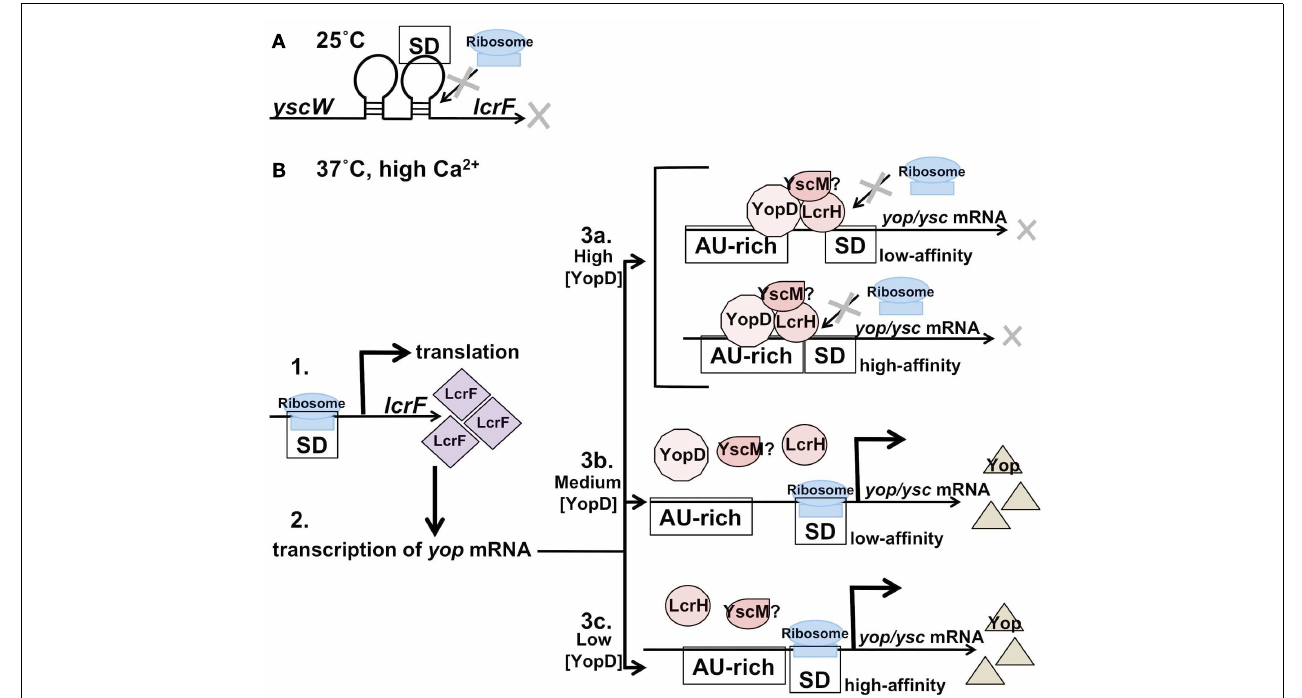
conditions exist. 3a. Under highYopD concentrations (little-to-no secretion exists) theYopD complex binds to both “high-affinity” and “low-affinity” AU-rich regions of specific yop transcripts. IntracellularYopD levels decrease as secretion is initiated. 3b. Under mediumYopD concentrations the “low-affinity” sites are released and translation proceeds. 3c. Under lowYopD concentrations the “high-affinity” sites are also released and translation of these proteins proceeds.This model suggests a hierarchy for yop / ysc translation that relies on the concentration ofYopD in the cell, which in turn is dependent on extracellular